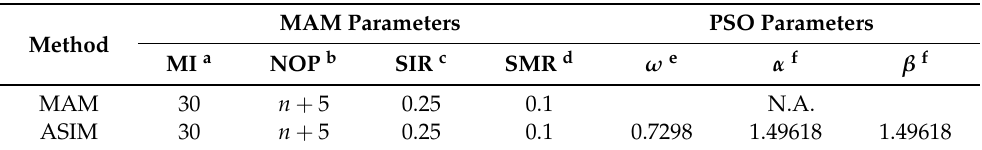
Table 2. Default parameters for MAM and